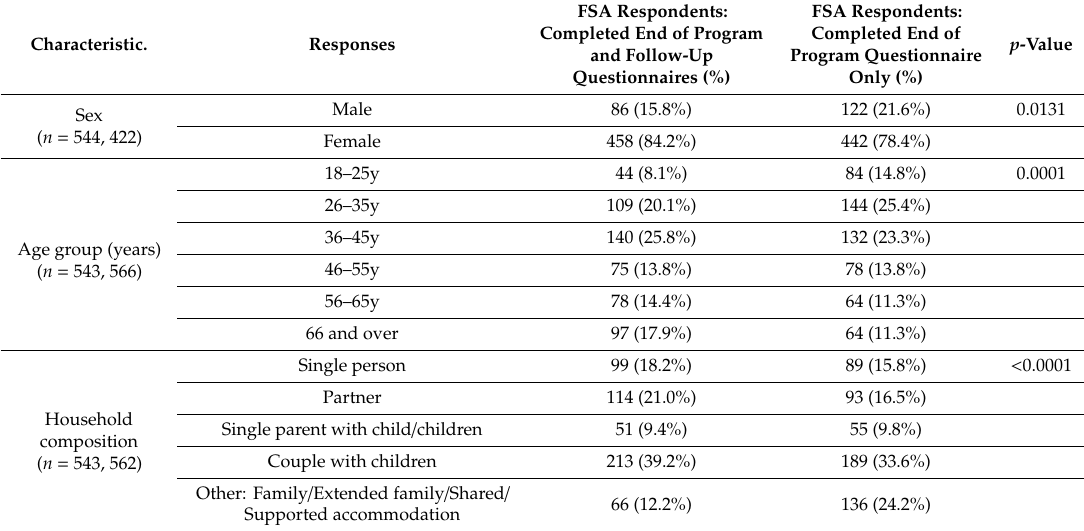
Table 1. Demographic characteristics of Food Sensations for Adults (FSA) participants who did and did not complete the follow-up